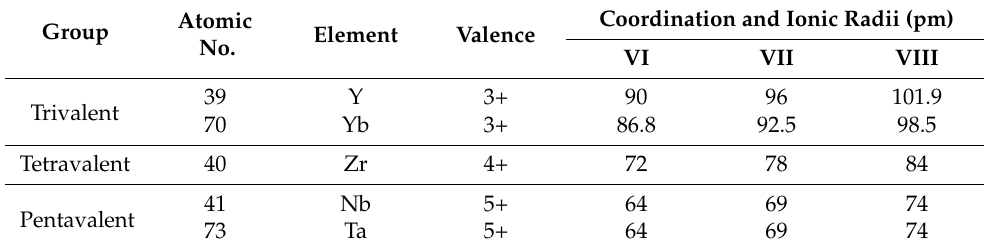
Table 2. Valence and ionic radii of co-doped elements used in this study. Group